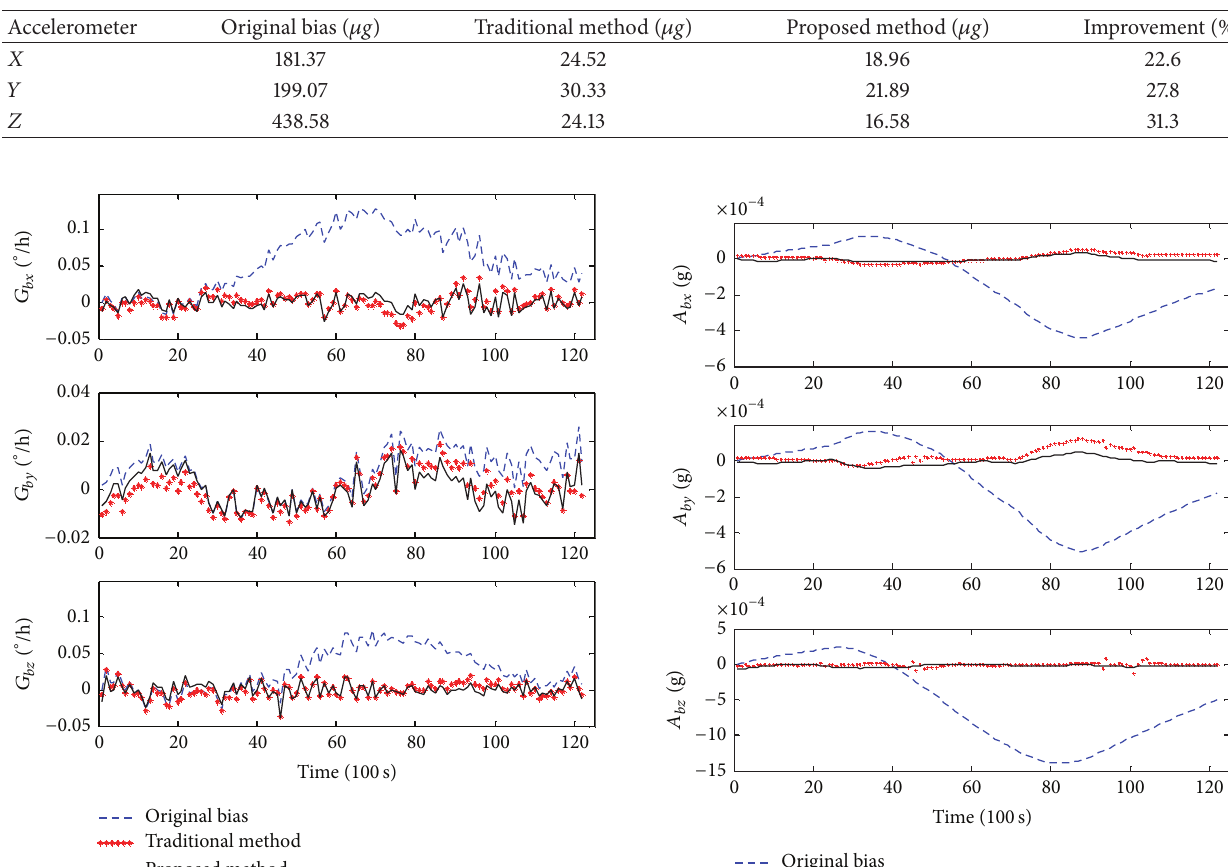
Table 2: The compensational results in accelerometer assembly.